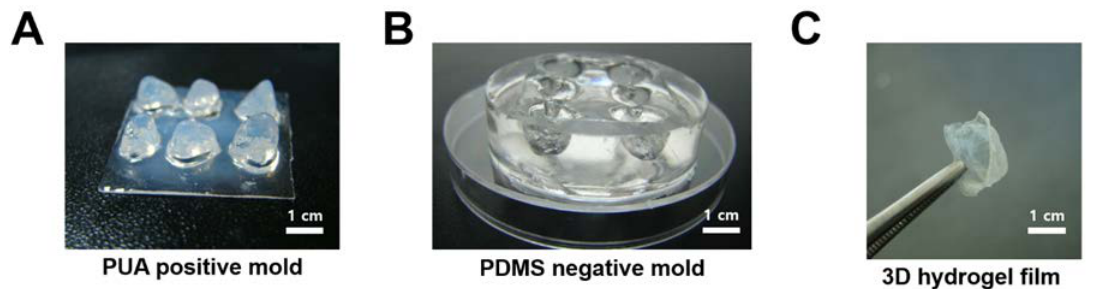
Figure 1. Photographic images of tissue-mimetic replica and 3D hydrogel structure. ( A ) Image of PUA-based cardiac- mimetic positive mold (replica). This positive replica was used as a master mold to produce PDMS-based negative mold. ( B ) Image of PDMS-based cardiac-mimetic negative mold. ( C ) Image of ALG-C film mimicking the structure of cardiac tissue surface.